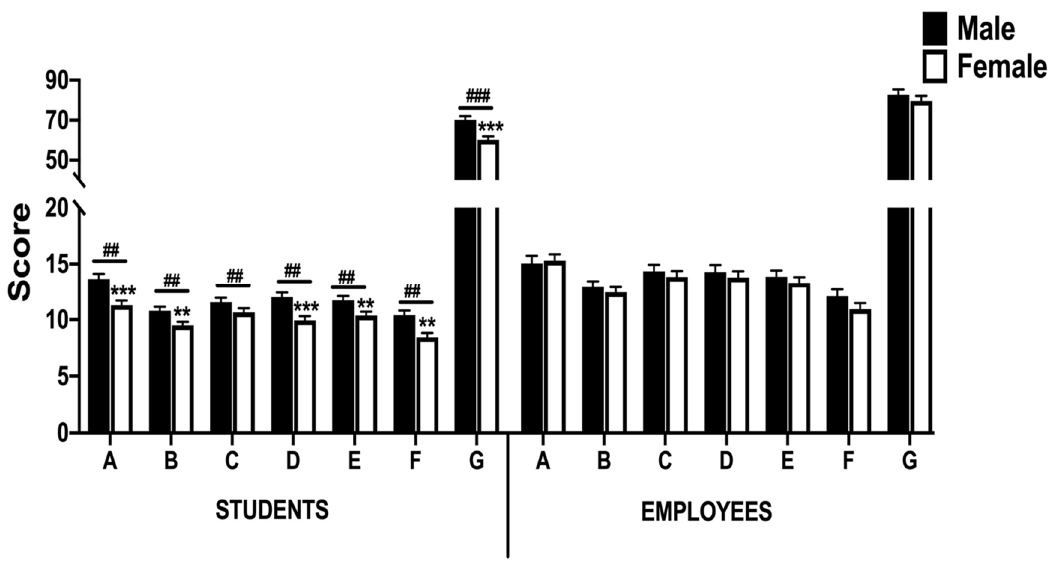
Figure 3. Score in the PGWBI-S test (PGWBI score and all six dimensions) in student and employee groups during lockdown. Bars represent mean ± SEM. A: anxiety; B: vitality; C: depression; D: self- control; E: well-being; F: general health; G: PGWBI score. A high PGWBI score represents greater well-being. **/*** denotes p < 0.01/0.001 compared to male students; ##/### denotes p < 0.01/0.001 compared to the employee group .